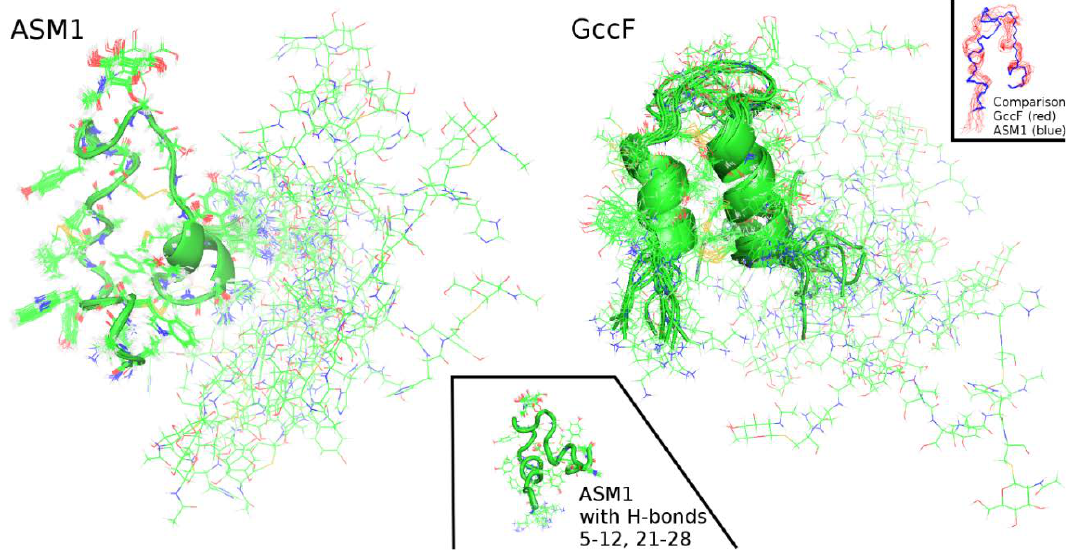
Figure 6. Comparison of solution NMR structures of ASM1 and Glycocin F (GccF). Superpositions of the 20 model structures of ASM1 and the 12 model structures of GccF (PDB: 2KUY). A comparison of the backbones 1–27 is shown in the insert on the right-hand side. The bottom insert represents a model of the ASM1 structure calculated using hydrogen-bond restraints for α -helices 5–12, 21–28; it resembles the GccF-model more closely .